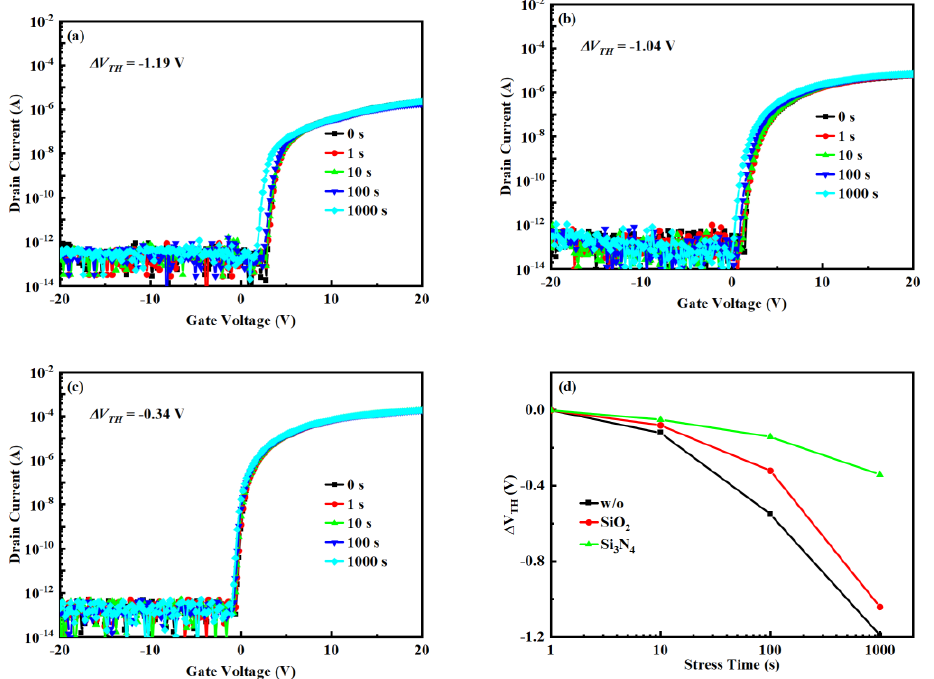
Figure 4. Evolutions of transfer characteristics of the IGZO TFTs with increasing NBIS: ( a ) w / o , ( b ) SiO 2 , ( c ) Si 3 N 4 , ( d ) Δ V TH as a function of stress time.